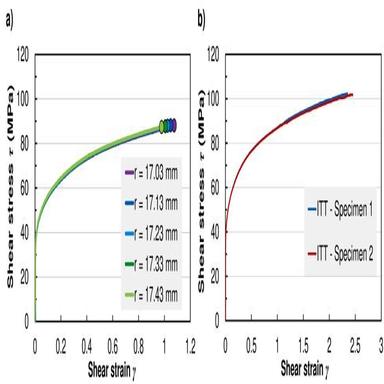
Monotonic ITT shear stress – shear strain curves for (a) a single specimen evaluated at different radii between 17.03 mm and 17.43 mm after the first stage of interrupted testing (b) total shear stress – shear strain curves for two specimens with interrupted testing (color should be used in print).